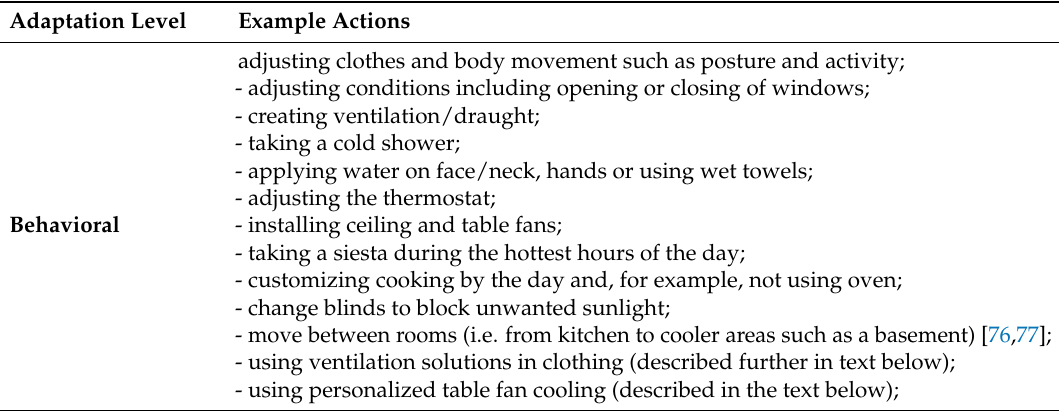
Table 2. Examples of actions at different adaptation levels of the individual.